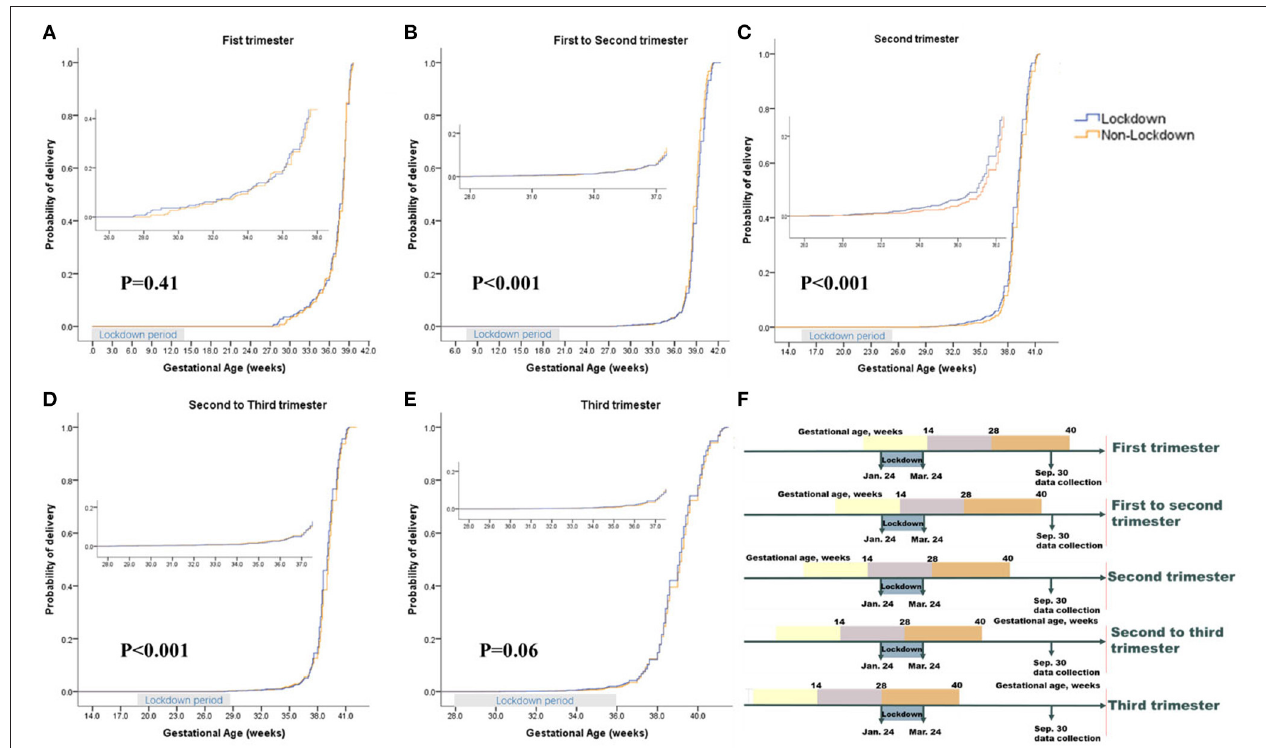
FIGURE 2 | Kaplan-Meier Curve for Lockdown and Non-Lockdown Groups in Propensity-Score-Matched Cohort and the Definition of Different Pregnancy Phases. This figure shows the probability of delivery among pregnant women who were in different pregnancy phases during Lockdown period in two groups. P -values were calculated through log rank test. The small picture in each picture is a partial enlarged picture of 28–37 weeks of gestation. (A) , Pregnant women who were in First trimester during Lockdown period. (B) , Pregnant women who were in First to Second trimester during Lockdown period. (C) . Pregnant women who were in Second trimester during Lockdown period. (D) . Pregnant women who were in Second to Third trimester during Lockdown period. (E) . Pregnant women who were in Third trimester during Lockdown period. (F) The definition of different pregnancy